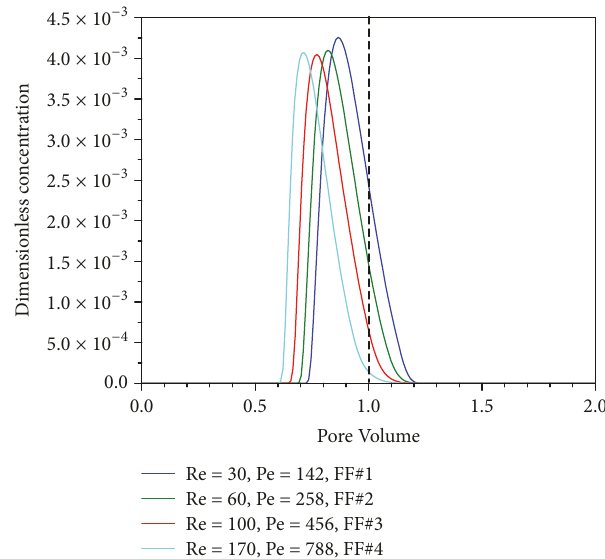
Figure 5: Breakthrough curves of compound A for the reaction transport under the different flow fields in the single self-affine fracture with Hurst exponent of